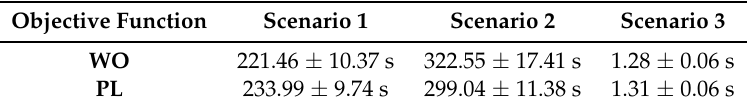
Table 14. Duration of simulations (mean ± standard